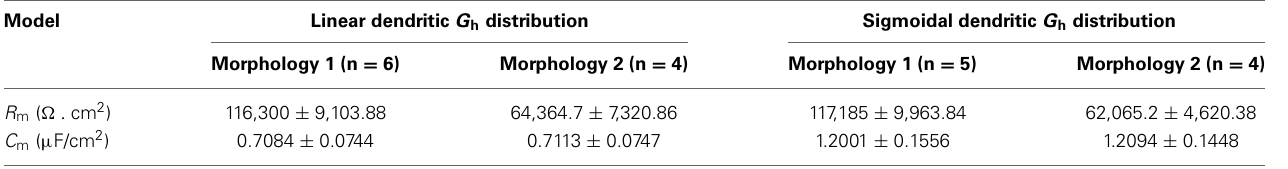
used on the models with morphology 1 (black dots). Black arrow denotes location of soma; green arrow denotes location of the injected EPSC. (C) Representative superimposed somatic and dendritic V m responses during the applied protocol; blue arrow denotes time at which the initial IPSC was evoked. The model shown is R4 linear, with IPSC-EPSC delay of 75ms. (D) Expanded view of traces corresponding to the dashed box in (C) showing the bAP measured, from the soma to the second dendritic spike (black line with arrows). The y-axis is shared with (C) .